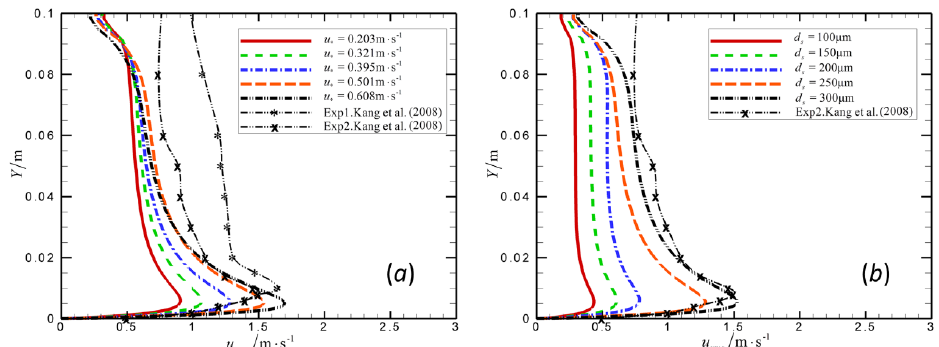
Figure 5. Variation with height of the fluctuation of sand velocity. ( a ) The profile varies with friction velocity. d s equals 250 μ m and 170 – 300 μ m for the present simulation and Kang, respectively [45]. ( b ) The profile varies with particle size. u equals 0.395 m/s and 0.353 m/s for the present simulation and Kang, respectively [45].